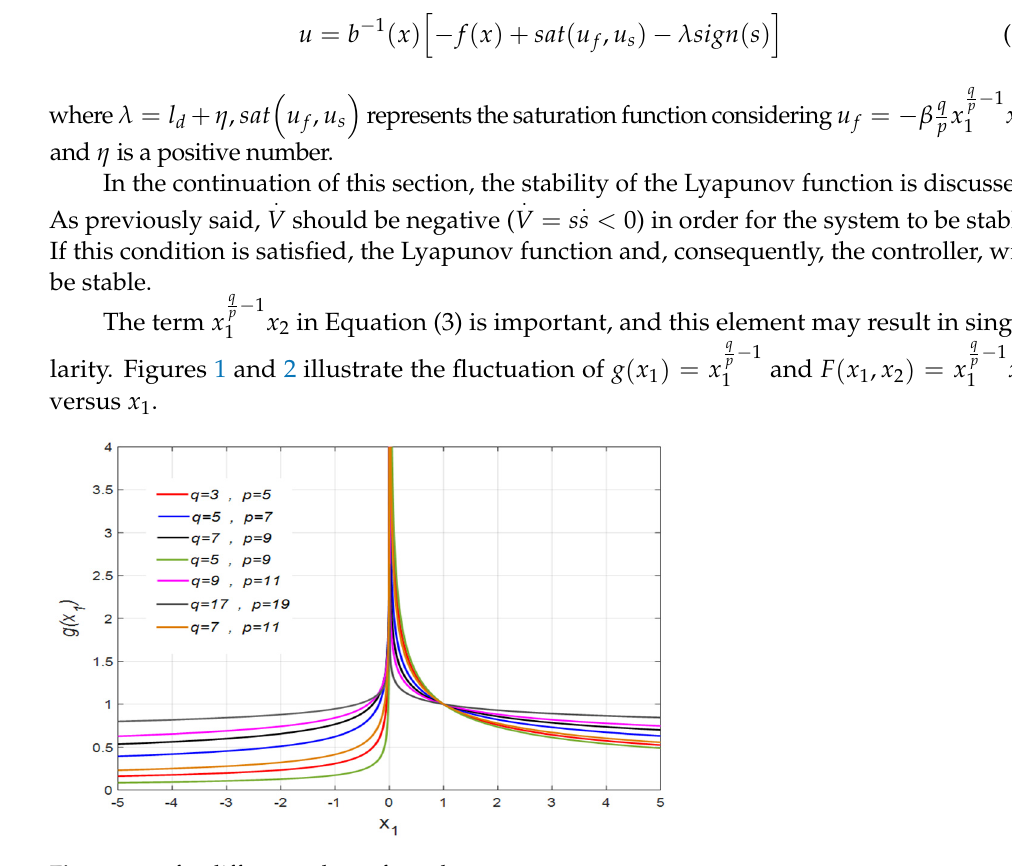
x Figure 1. x 1 for different values of q and p Figure 1. 1 for different values of